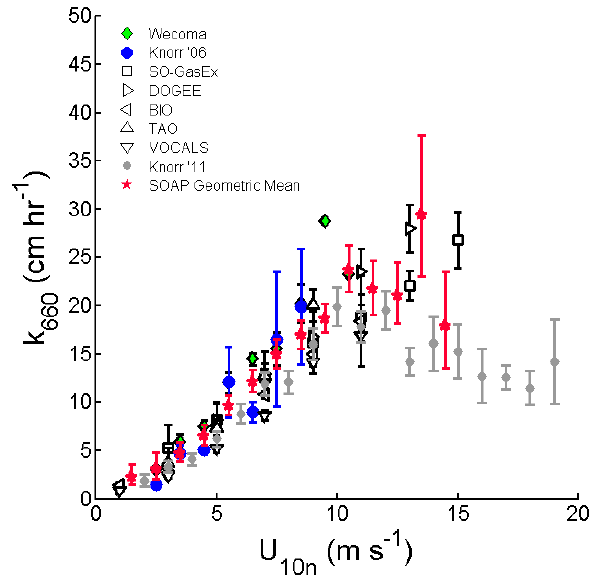
Figure 5. Bin average gas transfer coefficients from this study com- pared with prior published DMS eddy covariance measurements: Wecoma (Marandino et al., 2007), Knorr ’06 (Marandino et al., 2009), SO-GasEx (Yang et al., 2011), DOGEE (Huebert et al., 2010), BIO (Blomquist et al., 2006), TAO (Huebert et al., 2004), VOCALS (Yang et al., 2011) and Knorr ’11 (Bell et al., 2013). Ge- ometric mean SOAP k 660 values were calculated for 1ms − 1 U 10 n bins (error bars represent ± 2SE; minimum data points per inter- val = 6).